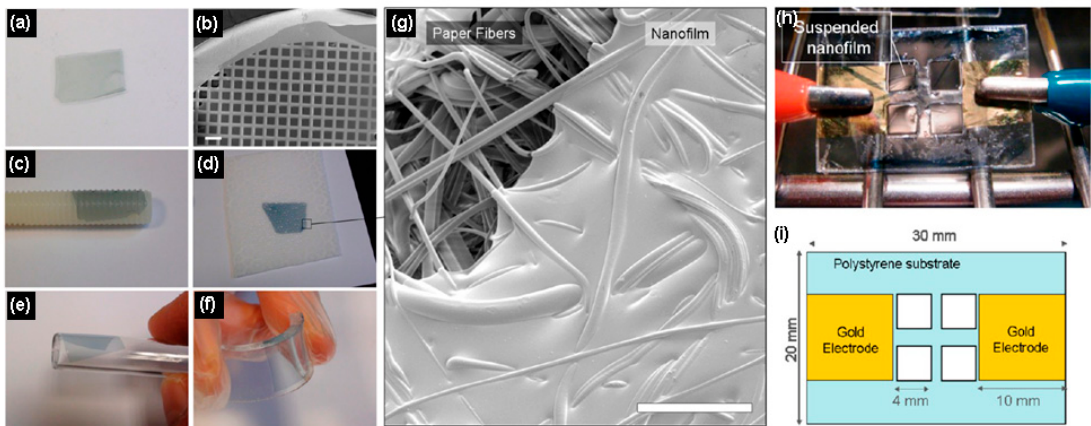
Figure 5. PEDOT:PSS/iron oxide nanoparticle composite nanofilms transferred to various substrates: ( a ) freestanding PEDOT:PSS/Nanoparticle 5 nanofilm (2 cm × 1 cm) floating in water after PVA dissolution. ( b ) SEM micrographs showing PEDOT:PSS/Nanoparticles 1 nanofilm collected onto a